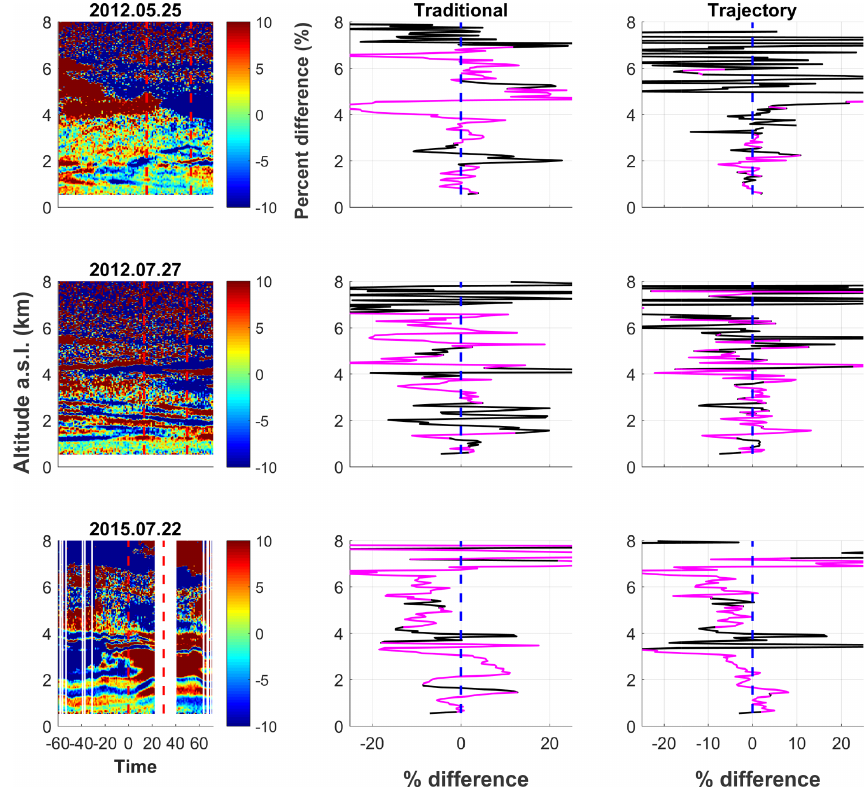
Figure 7. A subset of the dates with largely heterogeneous conditions showing the differences between the traditional and trajectory calibra- tion techniques. This figure follows the same format as Fig. 6 and shows that when the water vapour field changes over the 30min traditional calibration period, the traditional water vapour profile can look significantly different from the radiosonde. The trajectory method produces a profile with a smaller percent difference with respect to the